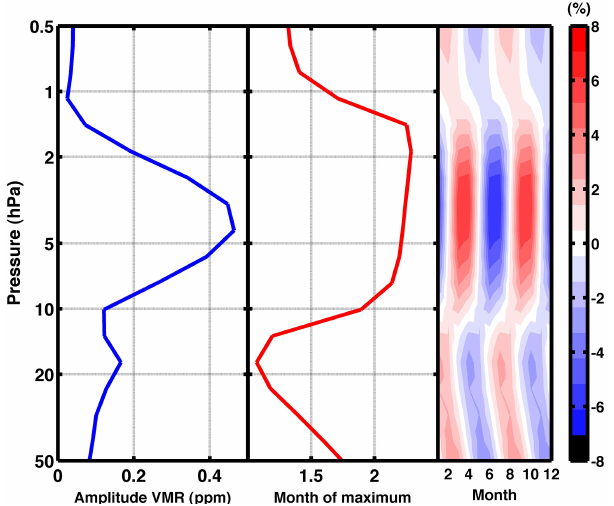
Figure 5. Amplitude of the temperature-, zonal wind-, meridional wind-, vertical wind-, ozone-SAO throughout the year at 3hPa. The ozone-SAO is multiplied by